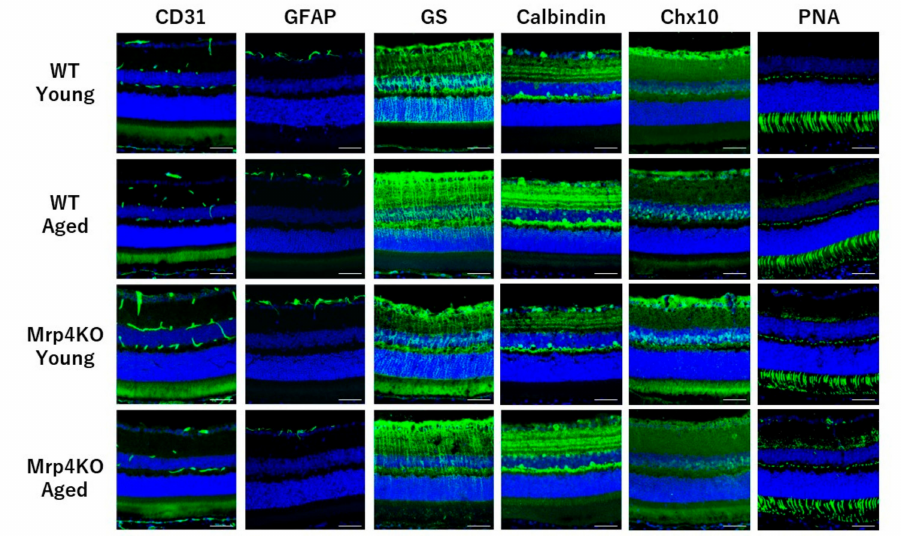
Figure 4. Immunohistochemical staining results of the retinal section. Bar = 100 µ m. WT, wild-type mice; Mrp4KO, Mrp4-null mice; GFAP, glial fibrillary acidic protein; GS, glutamine synthetase; PNA, peanut